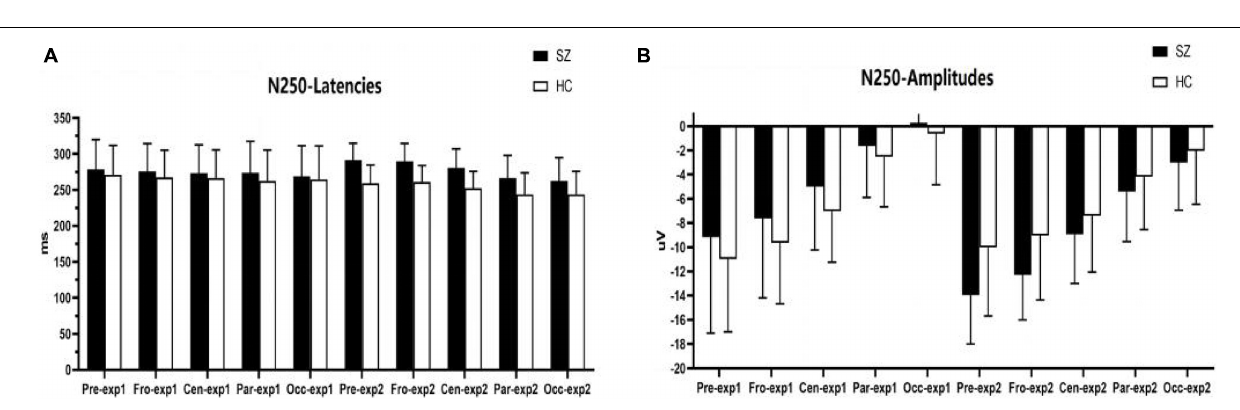
group × experiment ( F 1 , 64 = 0.053, p = 0.818, η 2 = 0.001); and group × site ( F 2 , 108 = 1.113, p = 0.324, η 2 =